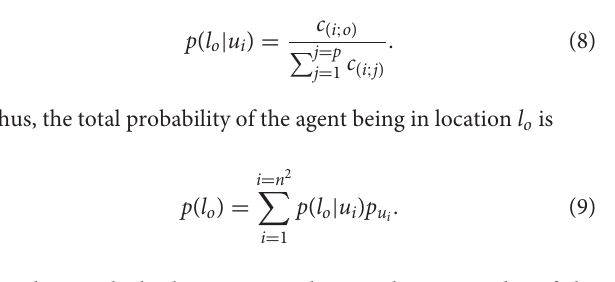
FIGURE 2 | Architecture of the proposed articulated tactile learning model for learning 3D object representations via translative movements ( translating left; : translating right and : translating back), orientational movements ( (cid:30) : orientating 90 ◦ counterclockwise and (cid:31) : orientating 90 ◦ clockwise), and → ↓ bending and unbending movements (denoted in dashed colored lines) as well as the navigator/agent state perception, which includes the agent’s shape and touching perceptions. MSOM units take the combination of the navigator state perception and the performed movement as their inputs, and then derive an activity pattern calculated in Equation (4). Based on the obtained activity pattern, the next action generator predicts what moves are possible in the current context. A possible action is stochastically selected to be executed. If the action selected is successfully performed, it updates the agent state and the performed action is an input to MSOM units. Otherwise, another action is stochastically selected until an action is successfully executed in the current